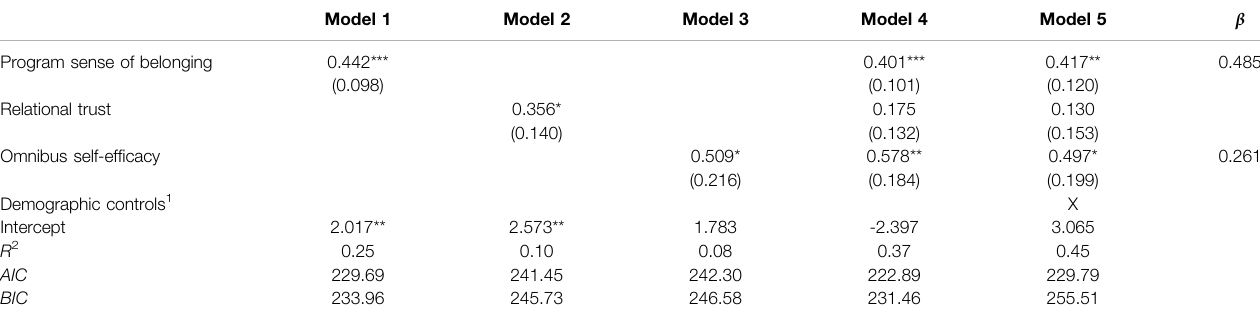
TABLE 3 | OLS regression preservice teachers ’ life satisfaction ( N (cid:1) 63).